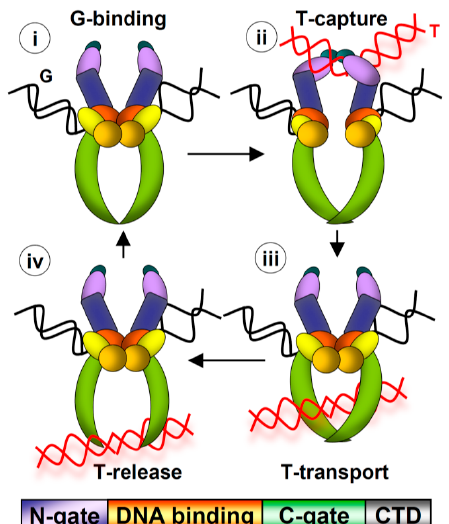
Figure 1. Top: Strand Passage Reaction. ( i ) G-segment DNA binds at catalytic core (orange/yellow/red), ( ii ) T-segment DNA captured by N-gate (purple/blue), G-segment cleavage, ( iii ) T-segment transport, G-segment ligation, ( iv ) T-segment release from C-gate (green). Bottom: Domain structure (colors match domains above). C-terminal domain (CTD; grey) has not been crystalized.